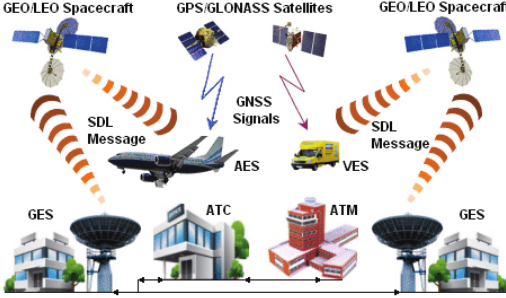
Figure 5. Aeronautical SADS-B System – Courtesy of Book: by Ilcev